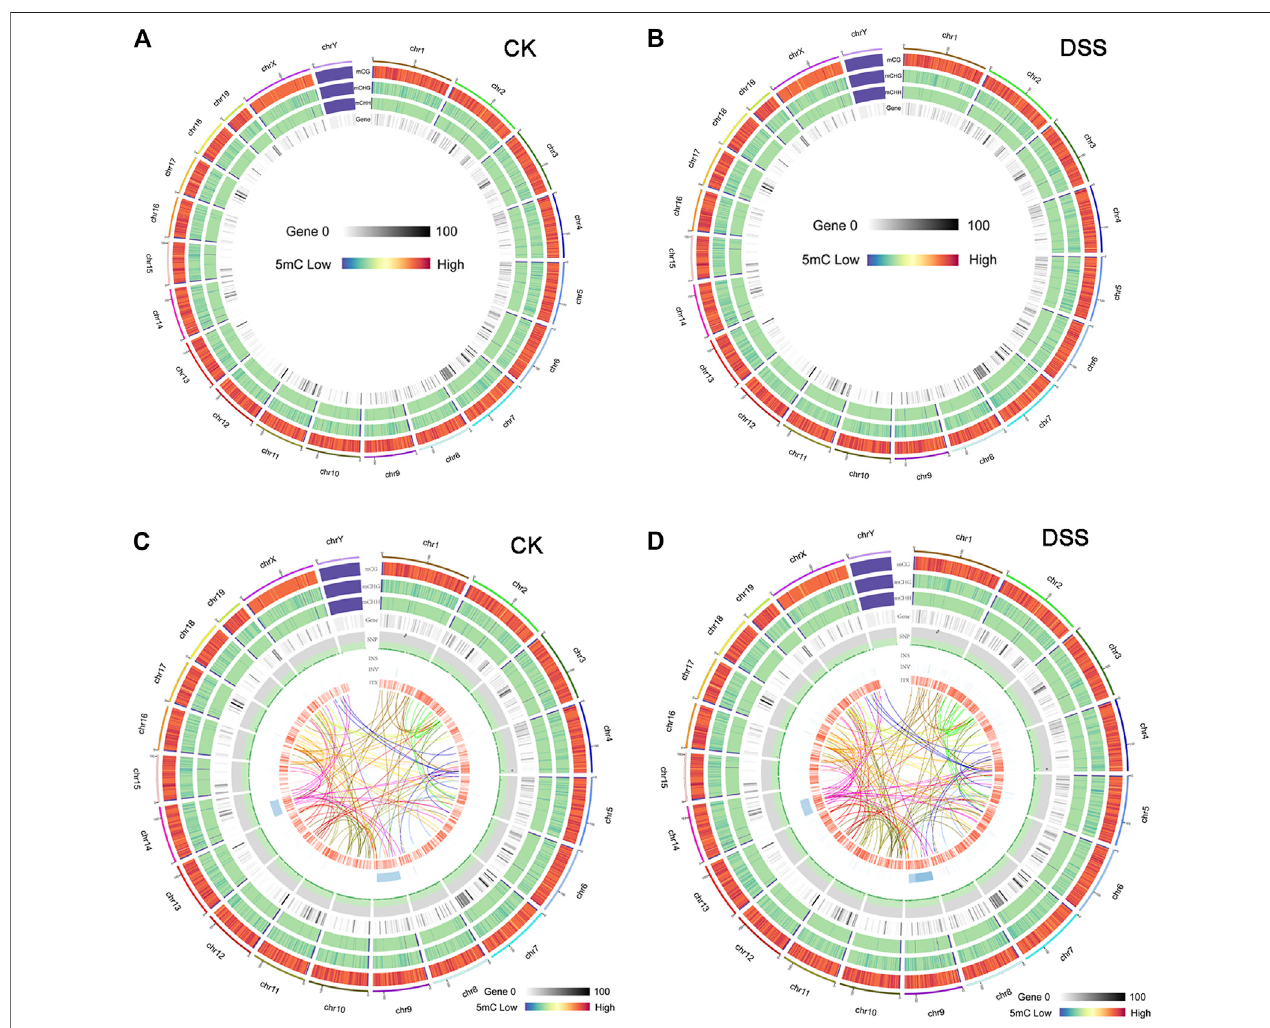
FIGURE 5 | The overview of DNA methylation in control and dextran sulfate sodium (DSS)-treated mice and the conjoint analysis of DNA methylation and gene mutation. (A, B) The genomic distribution of mCG, mCHG, and mCHH in two different groups of mice was presented in a Circos graphs. (C, D) The conjoint analysis of the DNA methylation and whole-exome sequencing (WES)